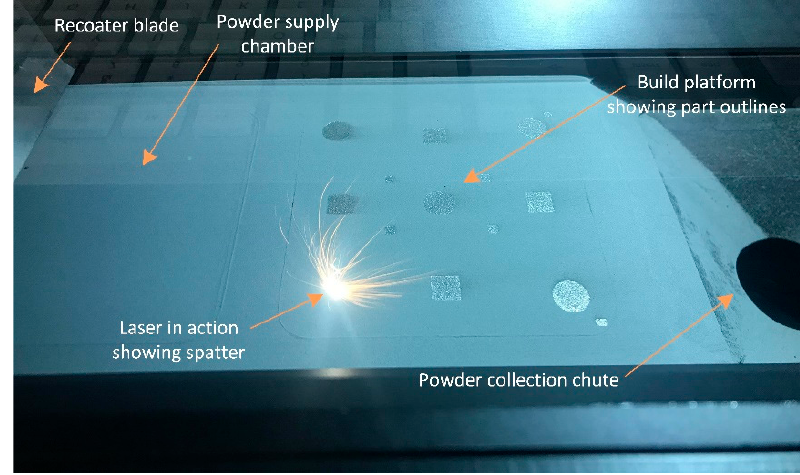
Figure 1. The laser-based powder bed fusion (L-PBF) apparatus and process.